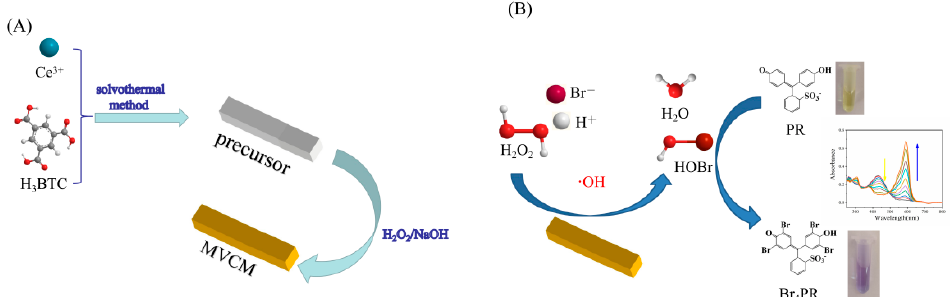
Figure 1. Schematic illustration of ( A ) the synthesis and ( B ) application of the MVCM nanozyme in ratiometric colorimetric detection of H 2 O 2 .